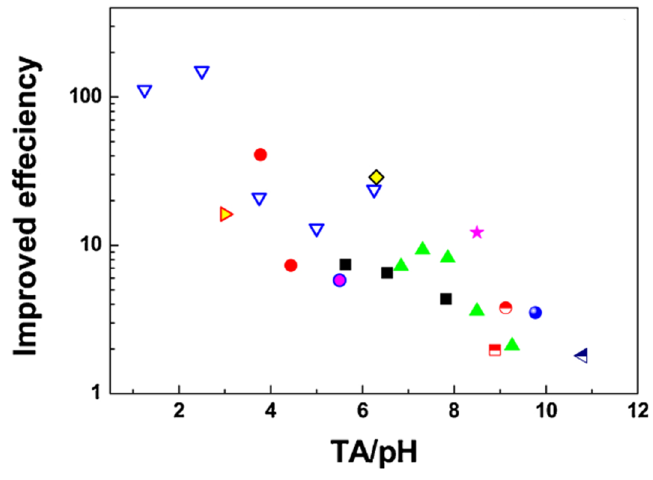
Figure 12. Relationships between the TA/pH and corrosion protection effectiveness of PCCs derived from the published data. Each symbol represents a specific published reference. The information of references can be found in [209], where the figure is taken from. Reprinted from [209] with permission from Elsevier.